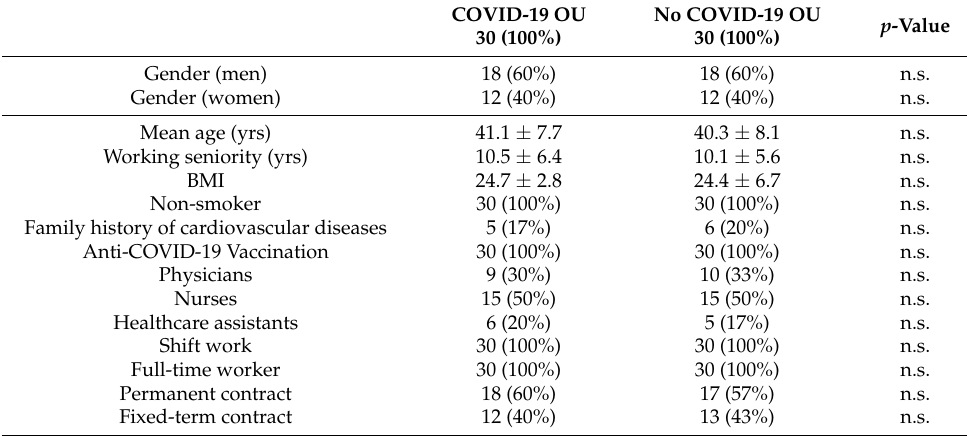
Table 1. Main characteristics of the